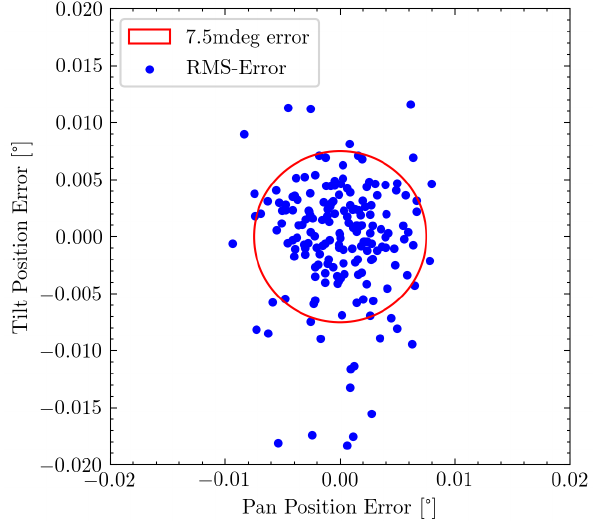
Figure 11. Relative RMSE of each individual measurement point. The red circle shows our require- ment accuracy of 7.5mdeg.